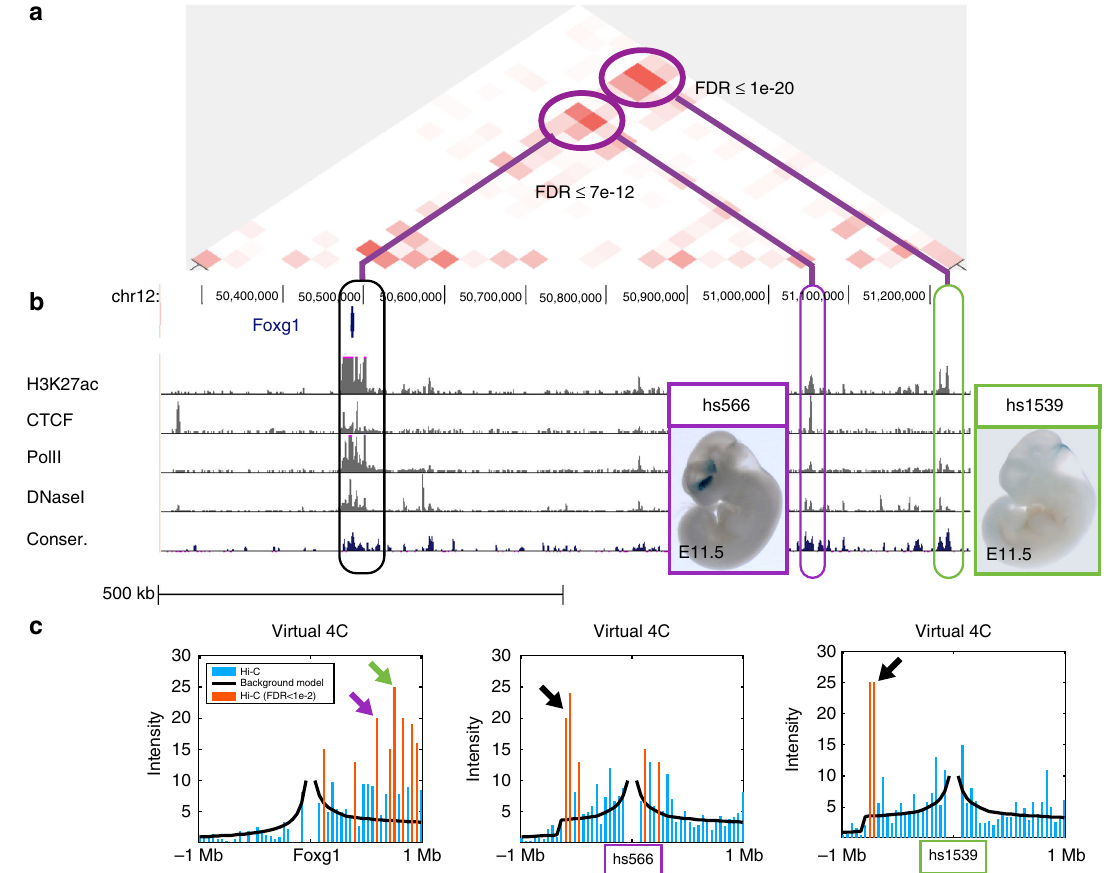
Fig. 2 Analysis of mouse cortex Hi-C data by PSYCHIC. PSYCHIC analysis of the Foxg1 locus in adult mouse cortex Hi-C data 25 identi fi es two putative enhancer bins enriched with Foxg1. a Residual map for the Foxg1 locus (chr12, 50.3 – 51.2 Mb) shows the measured Hi-C map after the subtraction of the background model fi tted by PSYCHIC, with two signi fi cantly enriched Hi-C cells, connecting Foxg1 with two putative enhancer bins. b ChIP-seq and evolutionary conservation data matching active enhancers, within the two putative enhancer regions. c Virtual 4C plots centered at Foxg1 (left) and the two enhancer loci (hs599 and hs1539), comparing measured Hi-C data (bars) vs. the fi tted background model as reconstructed by PSYCHIC (black line). Statistically signi fi cant DNA – DNA interactions (FDR < 0.01) are marked by orange bars. Arrows show signi fi cant interactions between Foxg1, hs566 and the hs1539 orthologous regions. Inset images (hs566, hs1539) from the VISTA Enhancer Browser by Visel et al